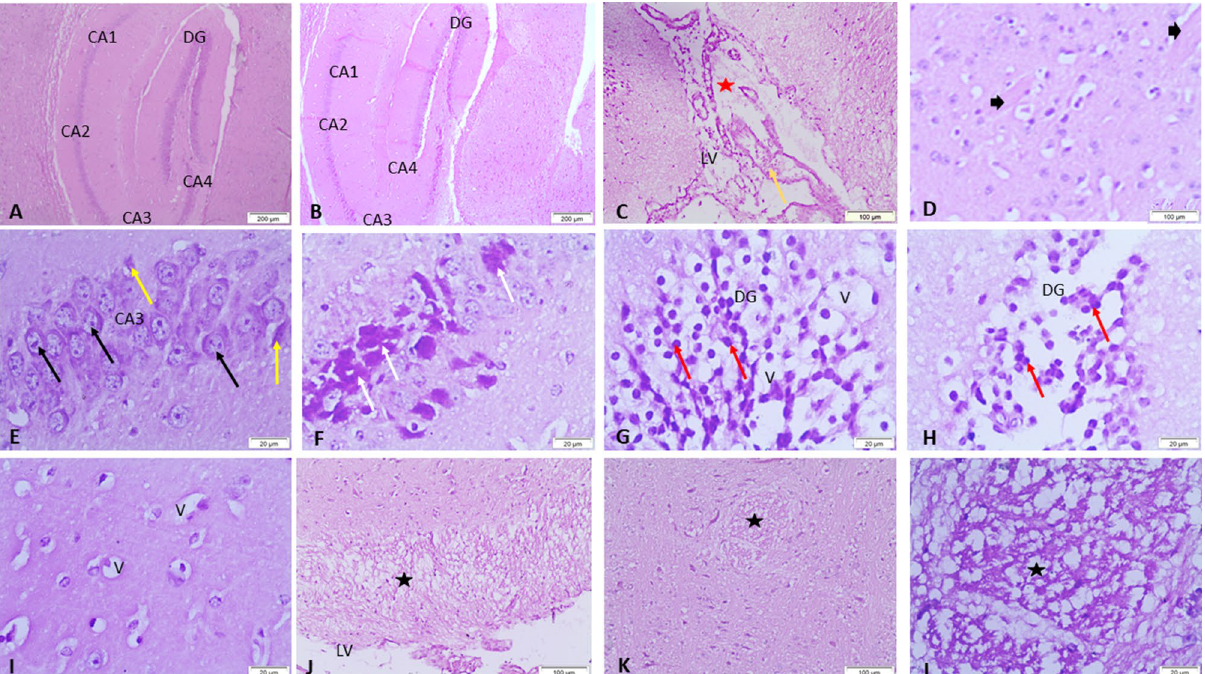
Figure 3. Representative micrograph of the control olive oil group showing the hippocampal region in the form of CA1, CA2, CA3 & CA4 regions and dentate gyrus (DG) is seen surrounding CA4 ( A ). ( B – L ); Representative micrograph of the bromobenzene group showing pathological changes in the hippocampal region, edema (red star) and congestion in blood vessels (orange arrow) in lateral ventricle (LV), amyloid substance (arrow heads), in CA3 region shows neurons with prominent nuclei (black arrows), apoptosis (yellow arrows), neuronal necrosis (white arrows), in DG region shows vacuolation (V) and apoptosis (red arrows), areas of extensive myelin vacuolation adjacent to LV with vacuolar clefts are typically empty and represent myelin sheath splitting (black stars).